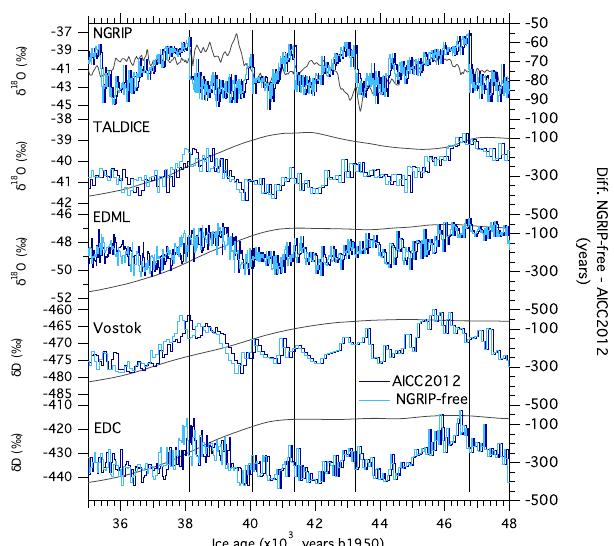
Figure 8. Comparison of NGRIP δ 18 O (NorthGRIP Community Members, 2004), TALDICE δ 18 O (Stenni et al., 2011), EDML δ 18 O (EPICA Community Members, 2006, 2010), Vostok δ D (Petit et al., 1999) and EDC δ D (Jouzel et al., 2007) water isotopes on dif- ferent coherent chronologies (AICC2012 in dark blue and NGRIP- free in light blue). The differences between the NGRIP-free and AICC2012 chronologies for each sites are represented by the black